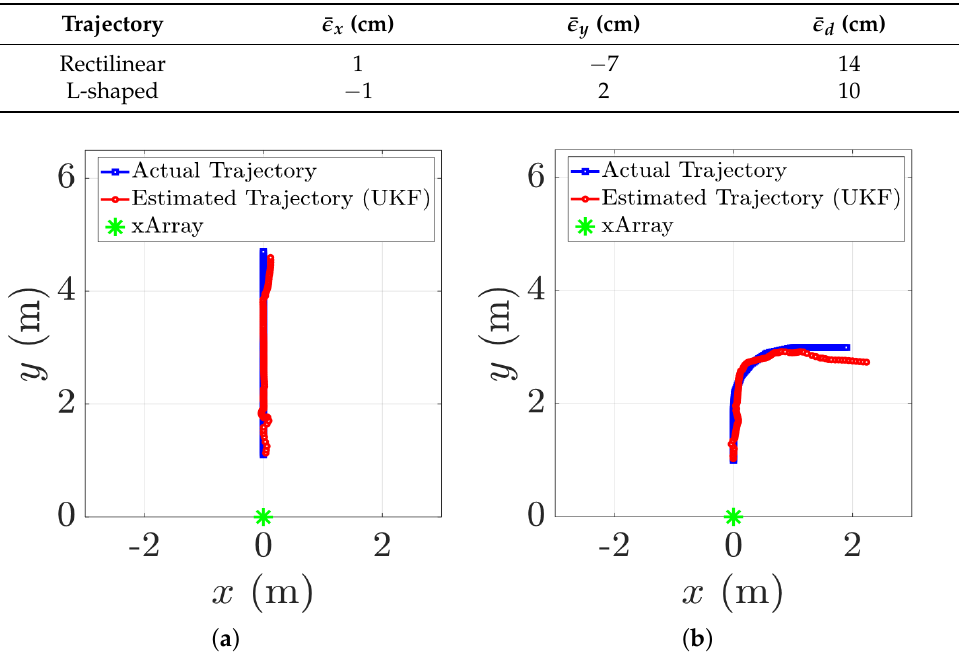
Figure 8. Actual (blue squared markers) and estimated (red circular markers) trajectories when the tagged person moves according to the following: ( a ) a sample of a straight path and ( b ) a sample of an L-shaped trajectory. xArray is represented with a green star